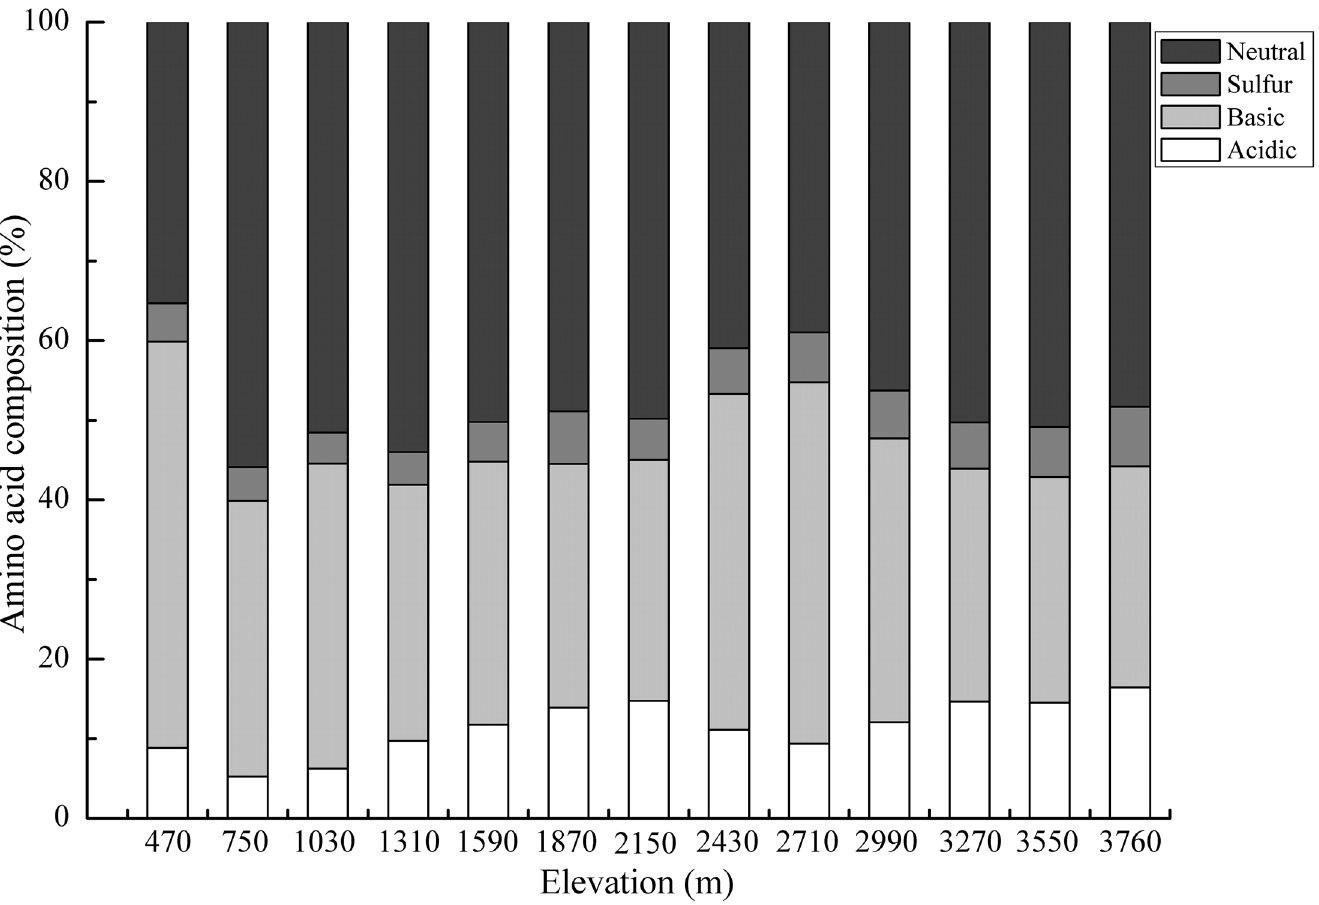
Fig 5. Proportions of the neutral, basic, acidic, and sulfur amino acids accounting for soil total hydrolyzable amino acids in the thirteen sampled elevations.